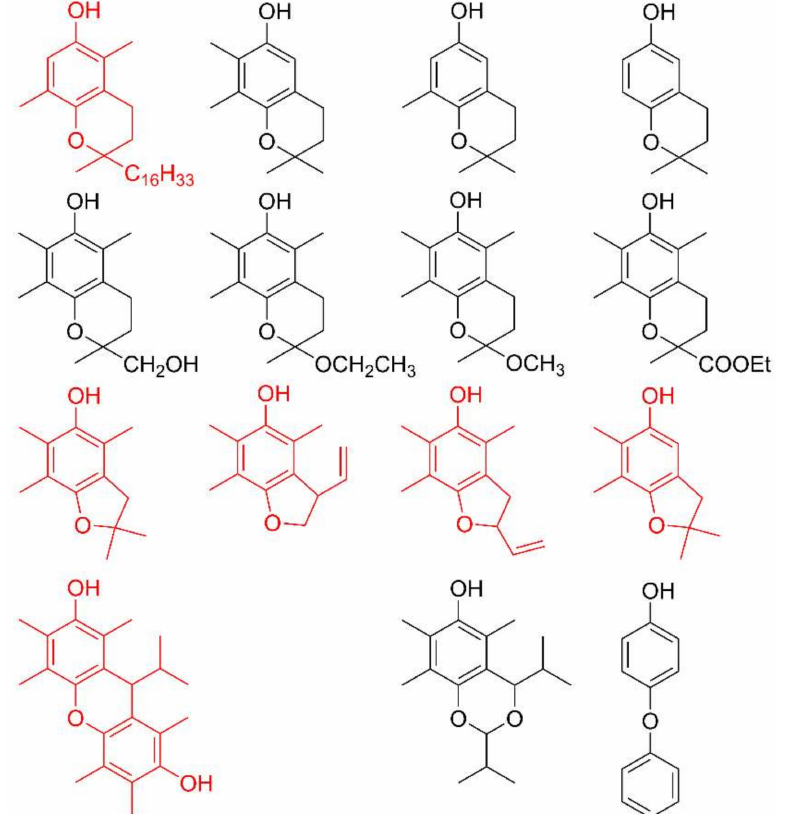
Scheme 5. Structures of phenolic compounds for electrochemical oxidation experiments [56,59]. Compounds in red show clear evidence of forming semi-stable diamagnetic cations when oxidized in a –2e − /–1H +